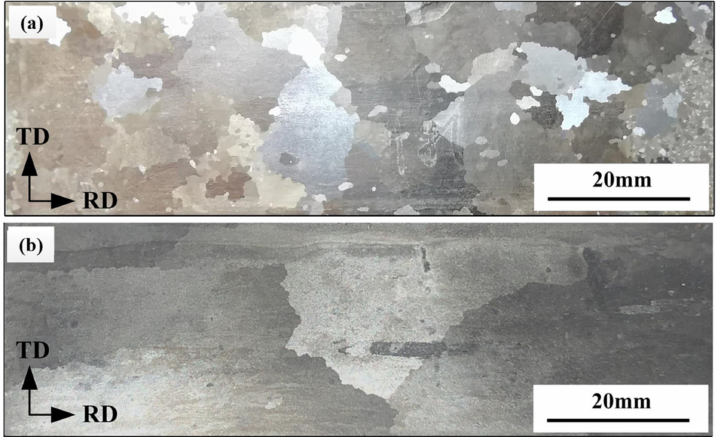
Figure 8. Macrostructure of secondary recrystallization sheets produced by ( a ) conventional and ( b ) twin-roll casting